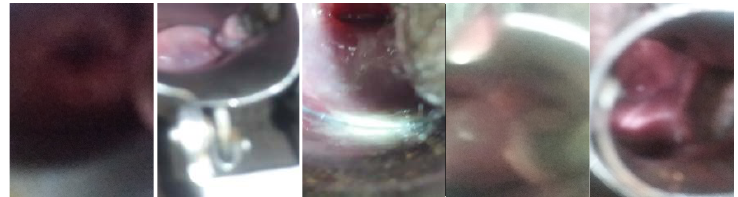
Figure 8. Samples of cervix images that are “misclassified” as non-cervix images.